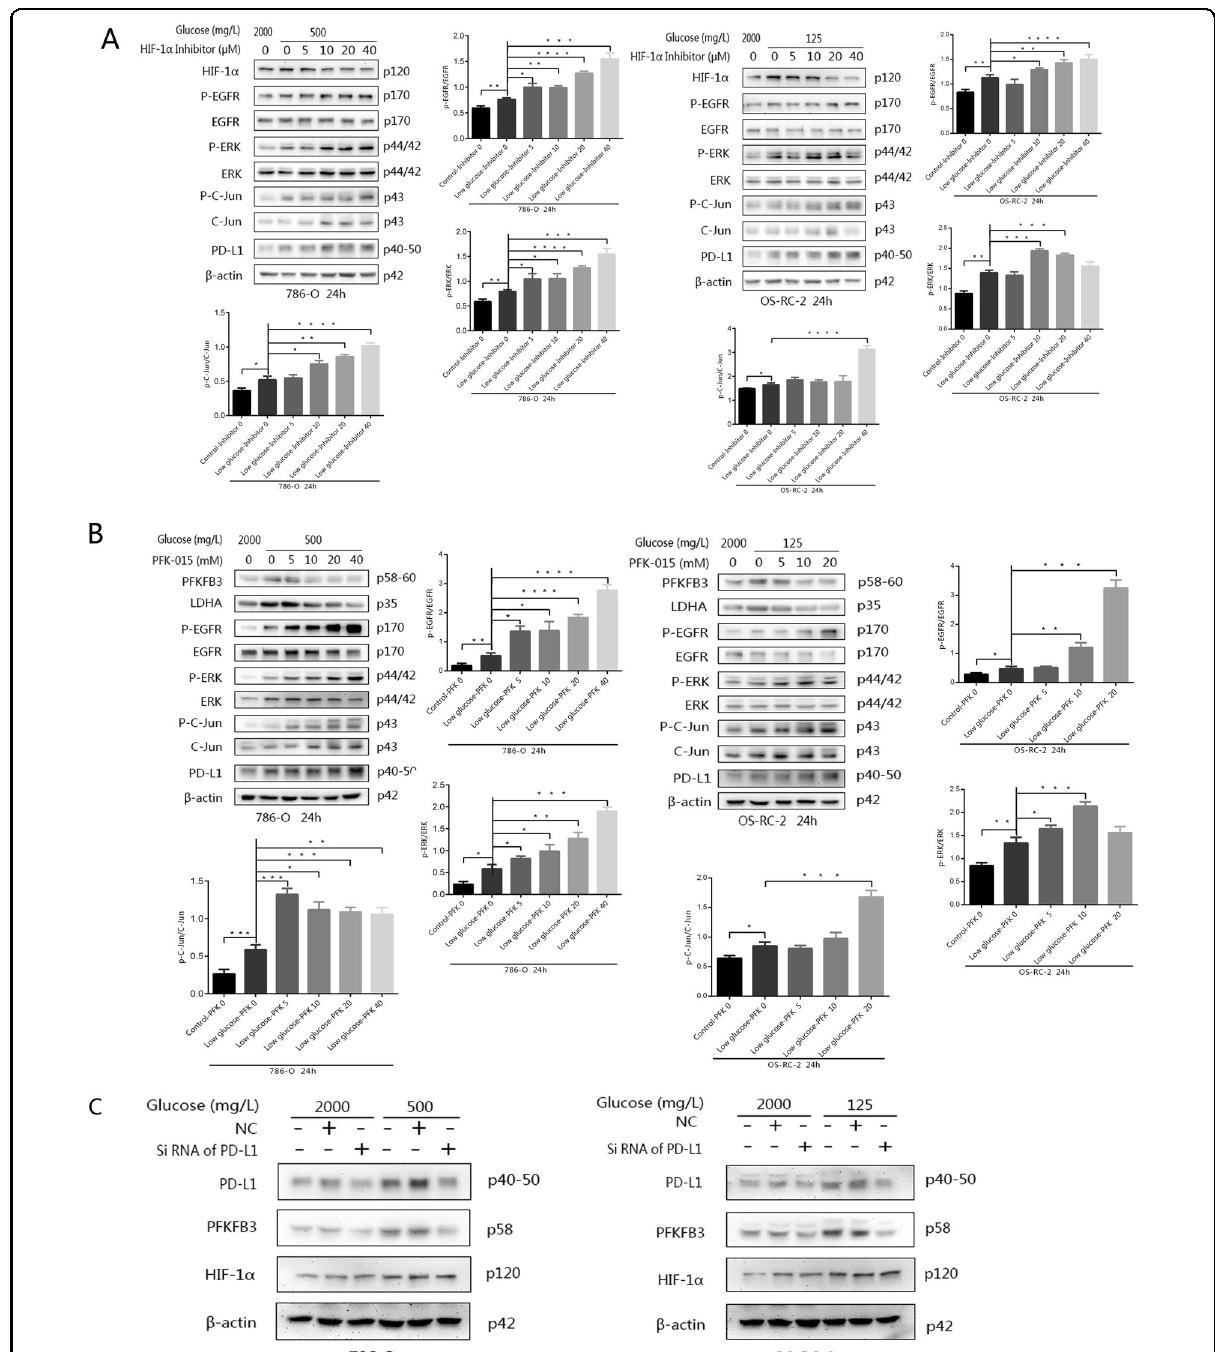
Fig. 6 The protein levels of EGFR, ERK, c-Jun and PD-L1 induced by adding different protein inhibitors to the RPMI 1640 or low-glucose culture medium system for 24 h were detected by western blotting. A The expression levels of the proteins mentioned above were observed after the addition of the HIF-1 α inhibitor YC-1. B The expression levels of the proteins mentioned above were observed after the addition of the PFKFB3 inhibitor PFK-015. C The expression of PFKFB3, a key enzyme in glycolysis, was observed in both cell lines when PDL1-speci fi c siRNA was added to normal- or low-glucose medium. Independent experiments were performed in